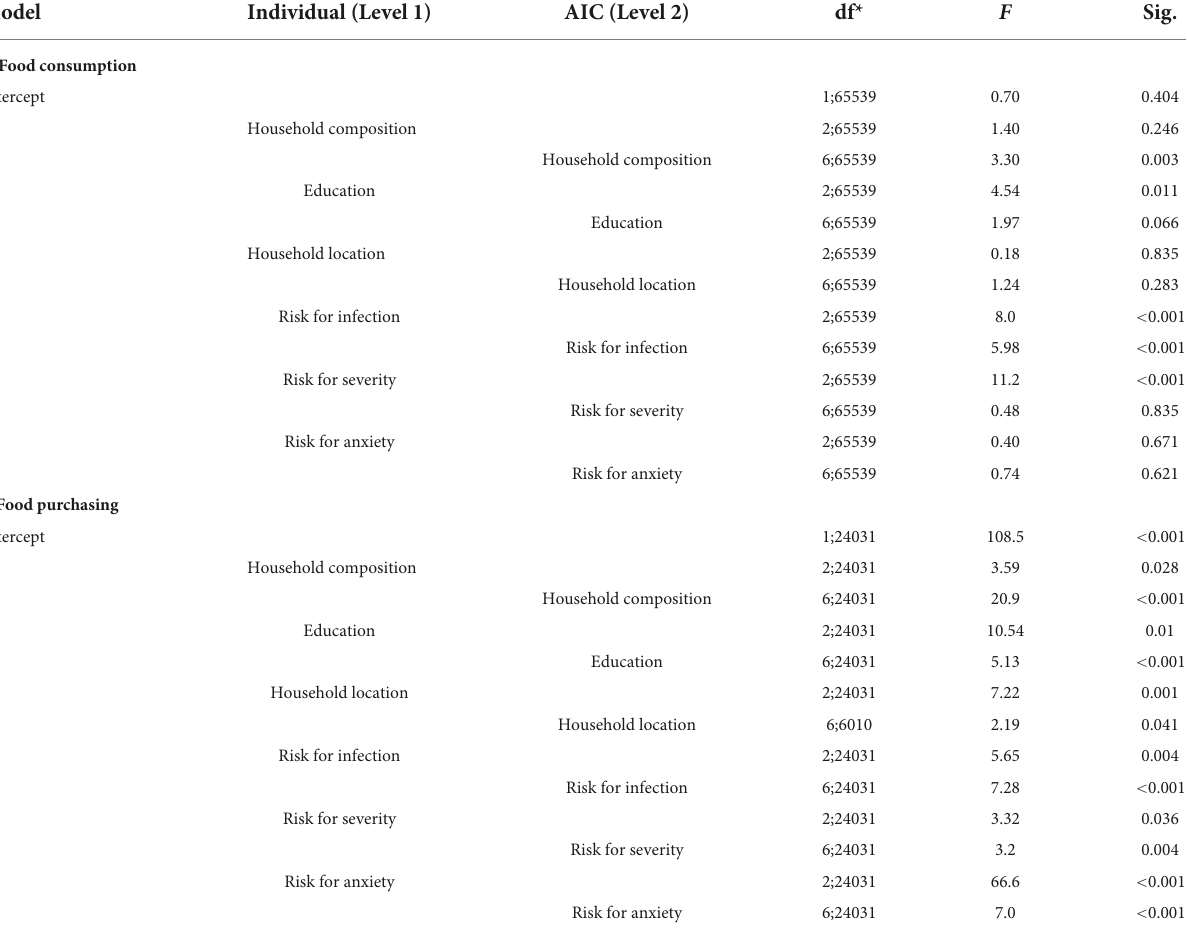
TABLE 6 Repeated measures mixed-model analysis with individual household and AIC levels of regional, household composition, educational, and COVID-19 risk perception effects on change in consumption and purchasing of food due to effects of the COVID-19 pandemic.